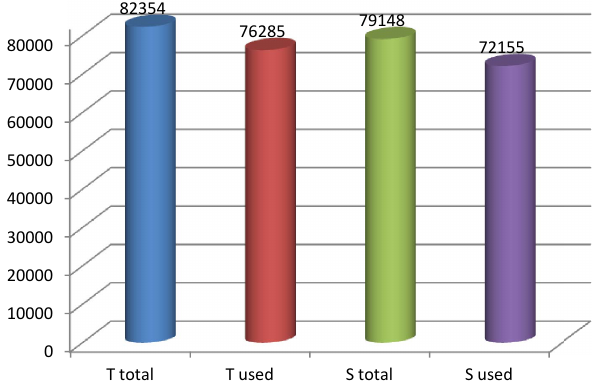
Fig. 3. Total number of observation points versus used number of observation points for temperature and salinity in situ